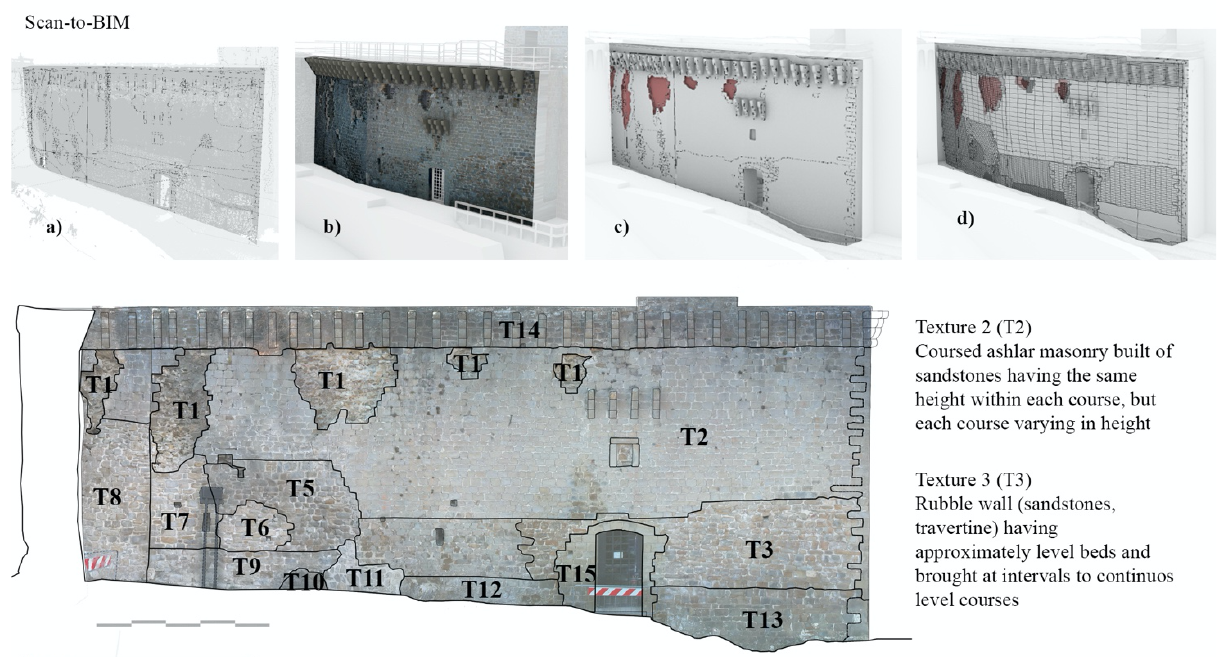
Figure 8. HBIM for Building Archaeology: stratigraphic units (texture) extracted from the NURBS: thanks to GOG9 and GOG10 it has been possible to directly identify the analysis in the 3D environment using NURBS algorithms: (a) point clouds; (b) textured model, (c) NURBS surfaces; (d) extraction of 3D primitives